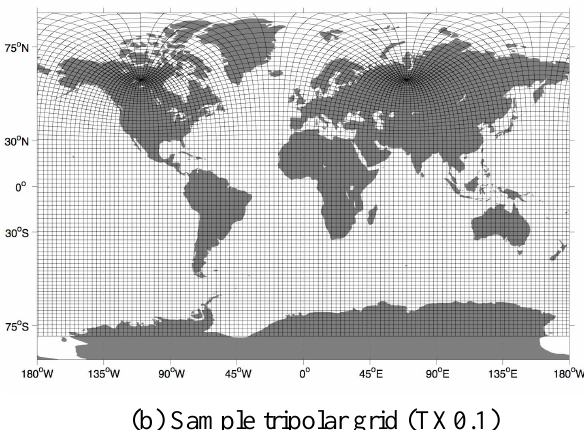
Figure 1. Orthogonal curvilinear grids for OGCMs.